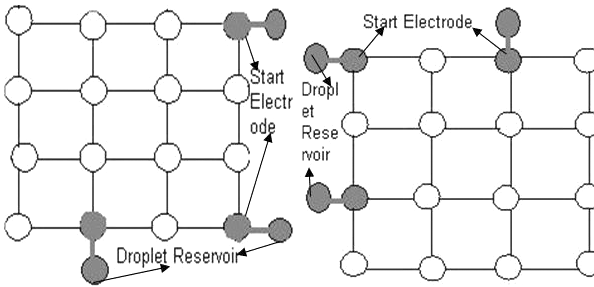
Fig. 4. Droplets placed on start electrode dispensed from source.